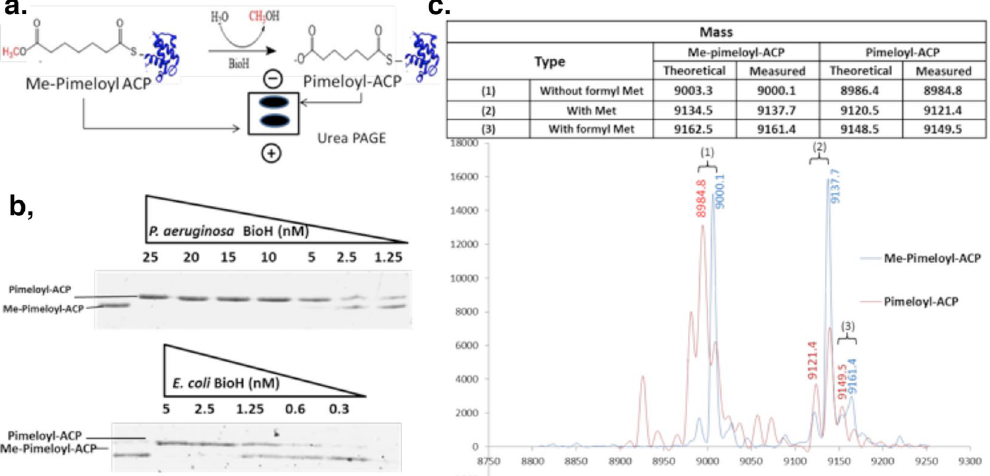
Figure 3. Enzymatic activities of E. coli and P. aeruginosa BioH proteins against pimeloyl-ACP methyl ester. ( a) Schematic diagram of the BioH catalyzed reaction and its analysis. ( b) Enzymatic assays for hydrolysis of pimeloyl-ACP methyl ester to pimeloyl-ACP by P. aeruginosa and E. coli BioH proteins. The triangles represent BioH levels in a dilution series. ( c) Mass spectrometric analysis of the BioH reaction. Only the P.